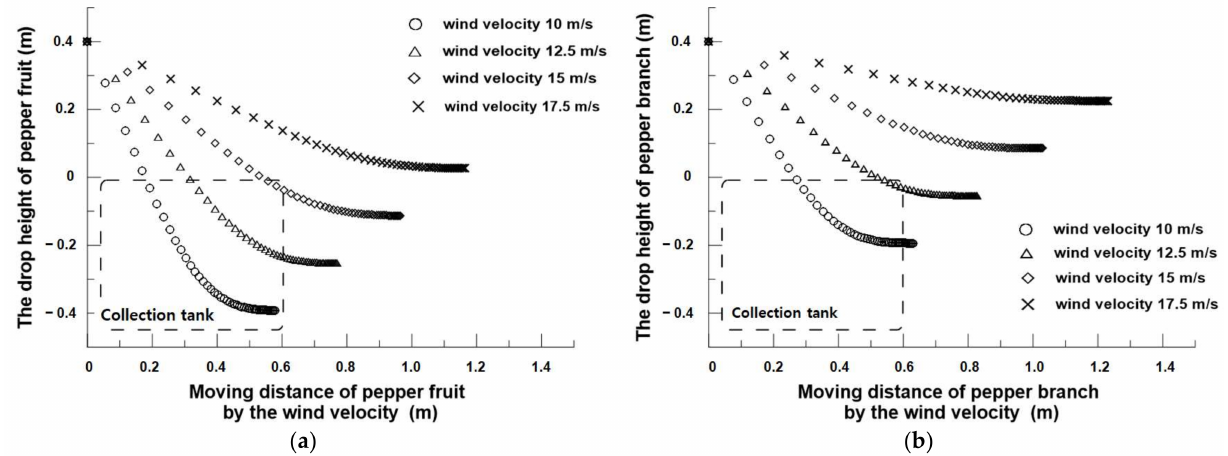
Figure 7. Graph of calculated moving distance for the pepper fruit ( a ) and the pepper branch ( b ) by velocity equation.